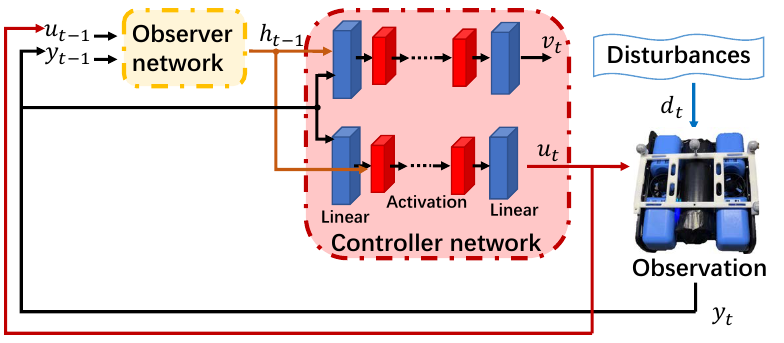
Figure 1. Network architecture of